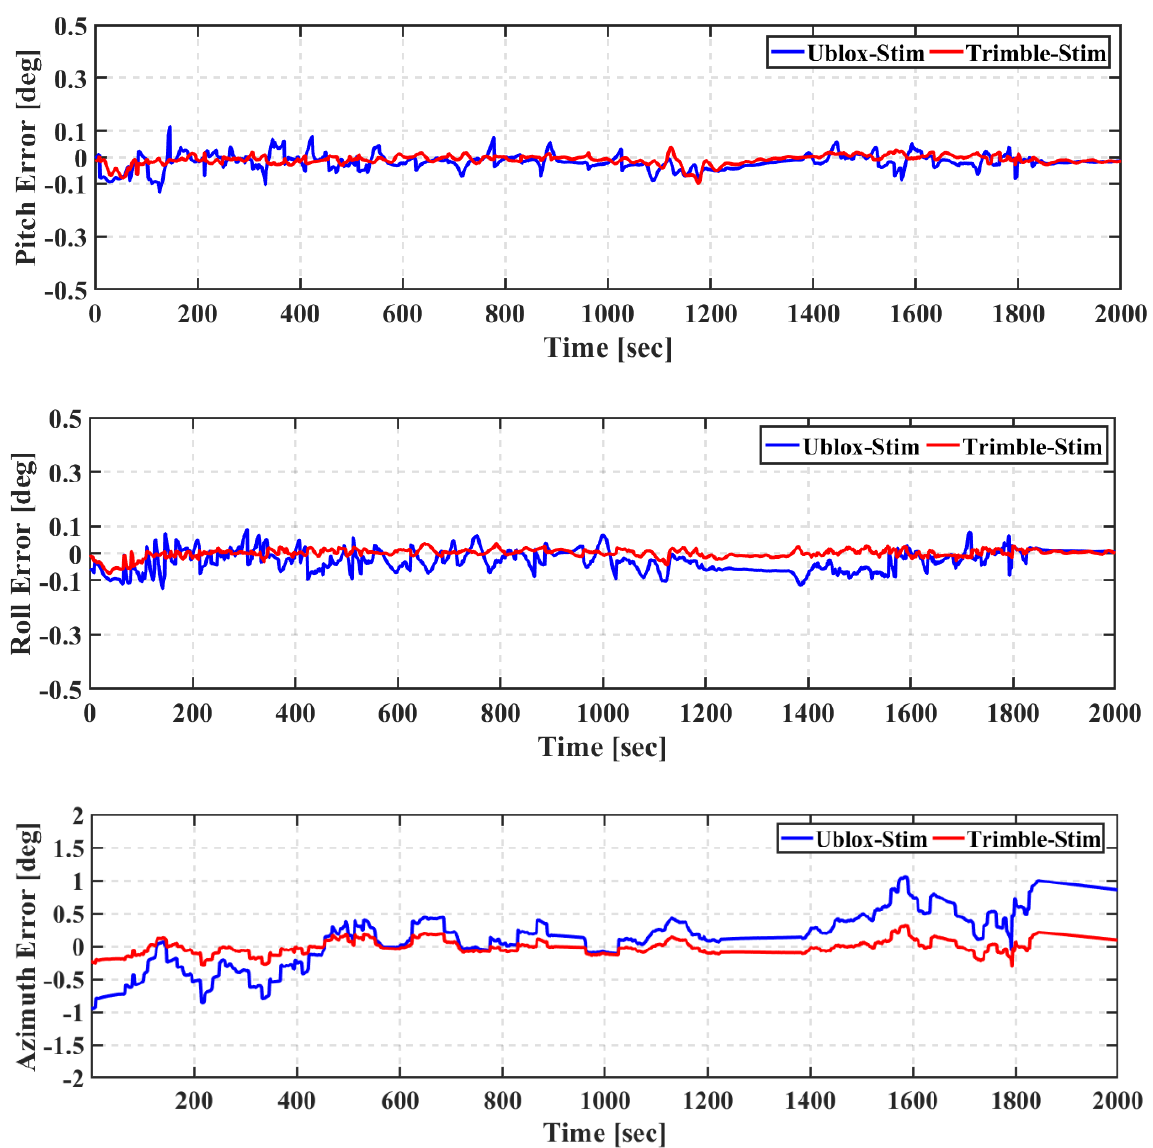
Figure 22. Third field trial: Pitch ( top ), roll ( middle ), and azimuth ( bottom ) of real-time TC GNSS PPP/INS for Ublox– Xsens and Trimble–Xsens solutions.